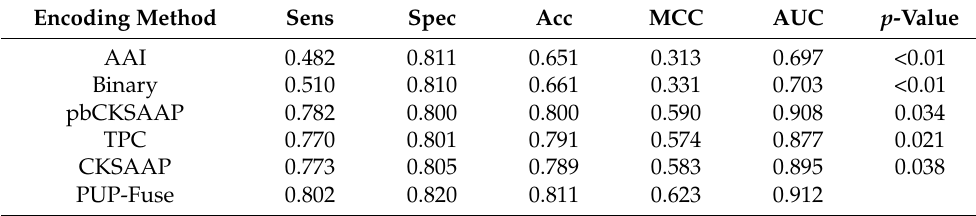
Table 1. Prediction performance comparison among the single encoding-employing models and their combined models without any feature selection on the training dataset. Encoding